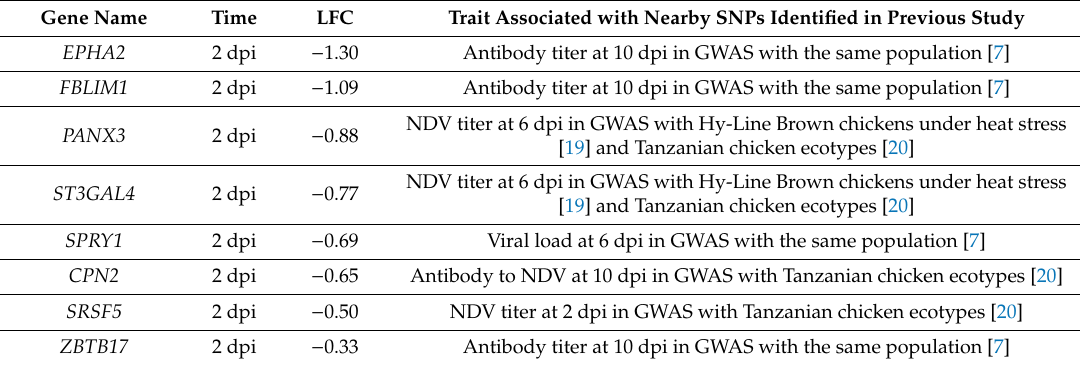
Table 5. DEGs near SNPs identified to be associated with NDV disease traits in previous GWAS studies.